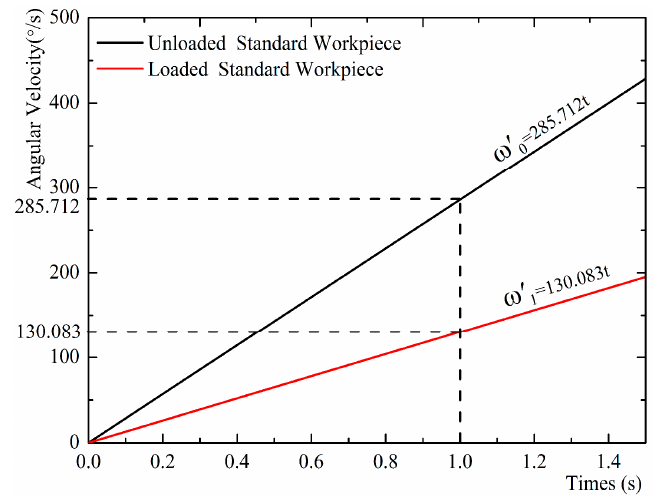
Figure 8. The relationship between angular velocity and time in different states.